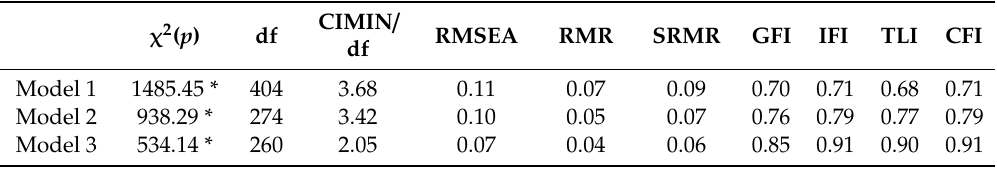
Table 3. Analysis of construct